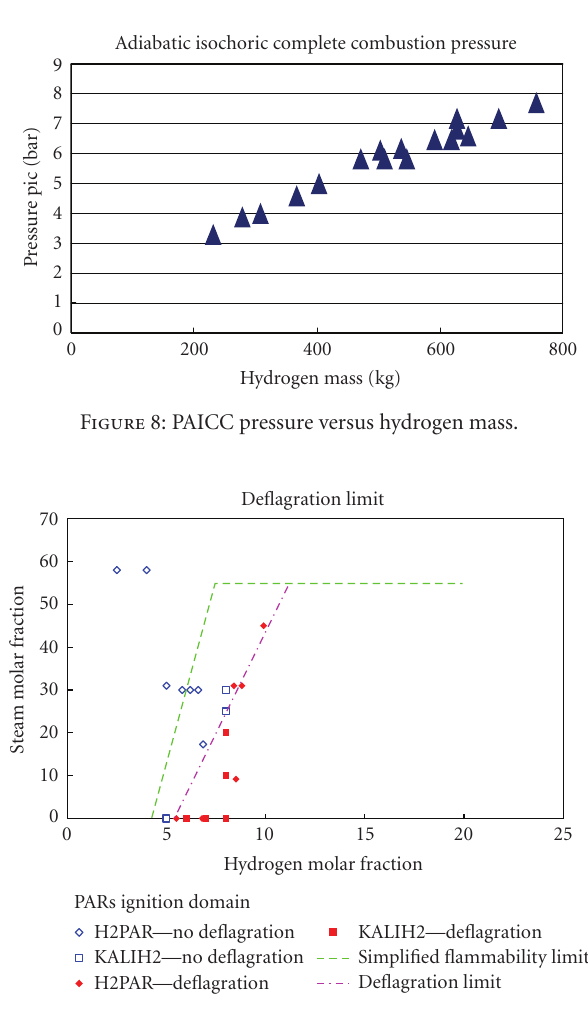
Figure 9: Ignition of SIEMENS